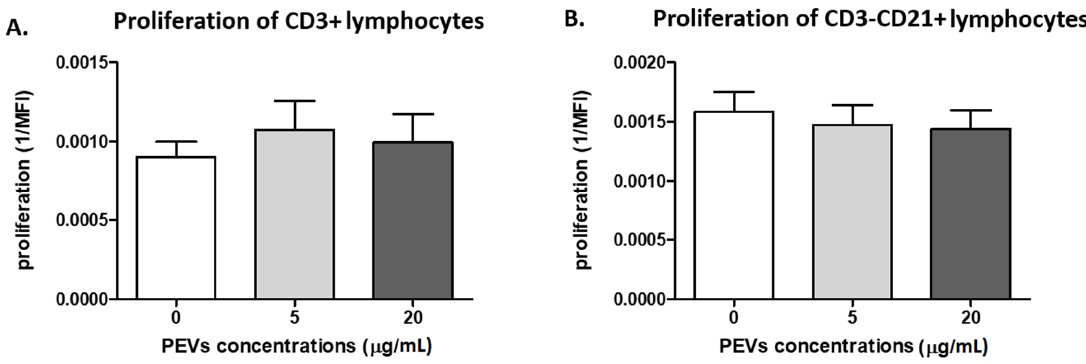
12.3 ± 3.1% and PEV2 13.1 ± 3.8%. The percentages of Th CM cells were 4.7 ± 1.2% in the control sample and 5.7 ± 1.8% and 5.6 ± 1.5% for PEV1 and PEV2 EM cells. The most numerous were EM cells: in the control sample 53.6 ± 8.2%, for PEV1 55.4 ± 9.5% and PEV2 57.4 ± 9.7%; the TEMRA percentages were as follows: 30.3 ± 63%, 26.4 ± 5.8% and 23.9 ± 5.2% (Figure 4A).